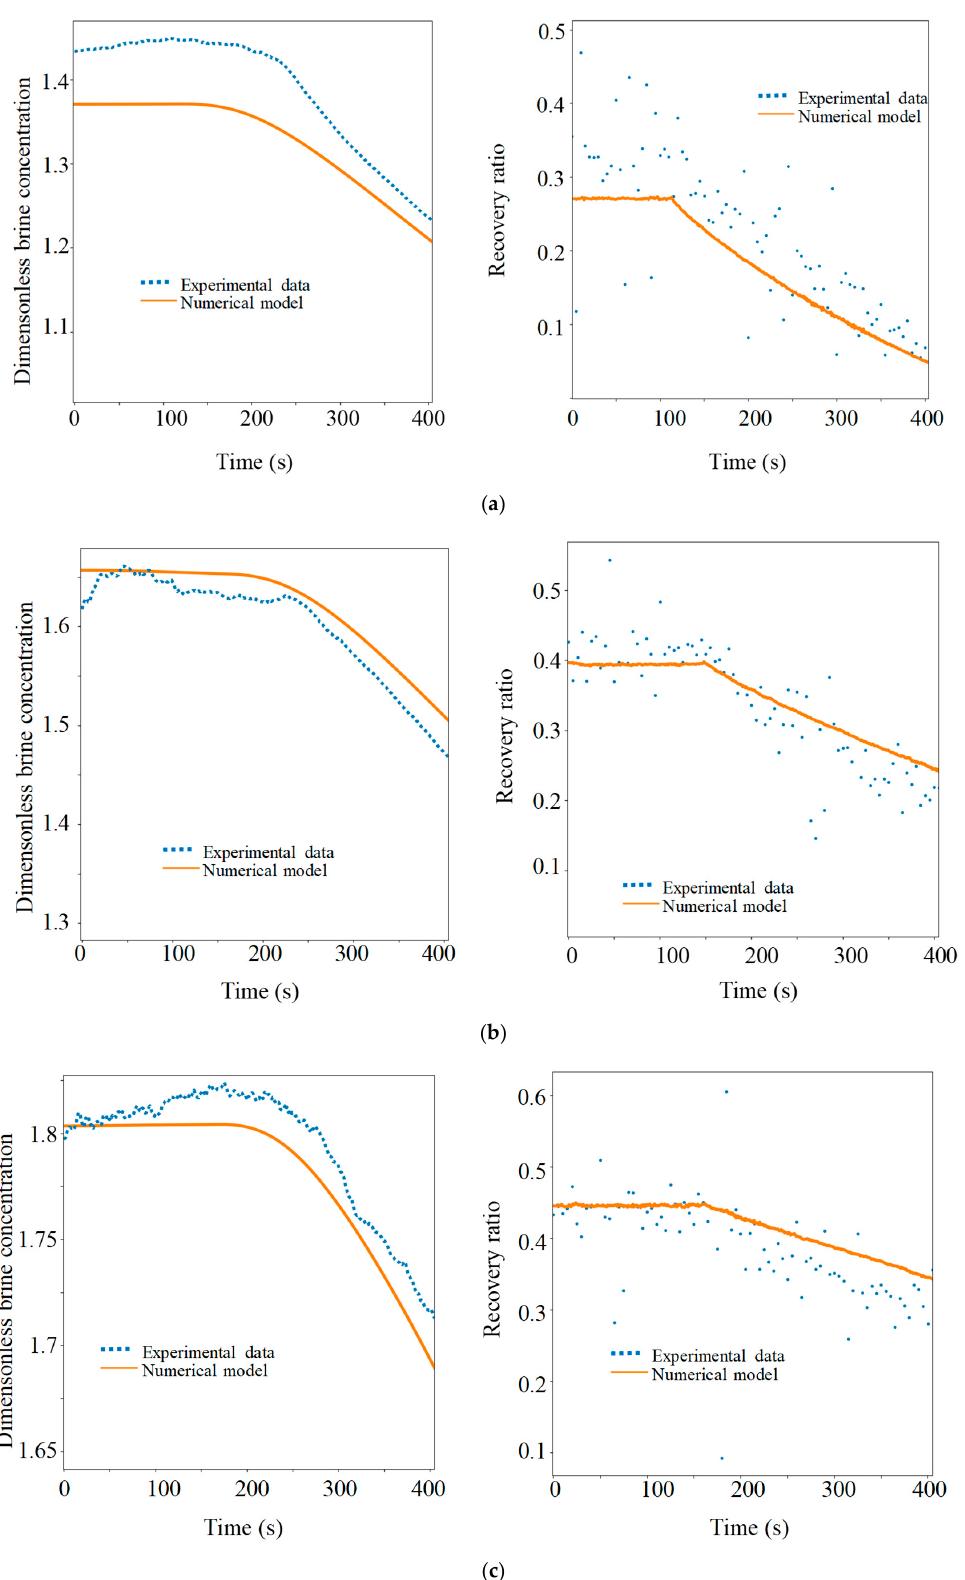
Figure 12. Comparison of experimental data with the simulated results obtained by the dynamic model for different starting pressures: ( a ) 7 bars, ( b ) 10 bars, and ( c ) 12 bars.